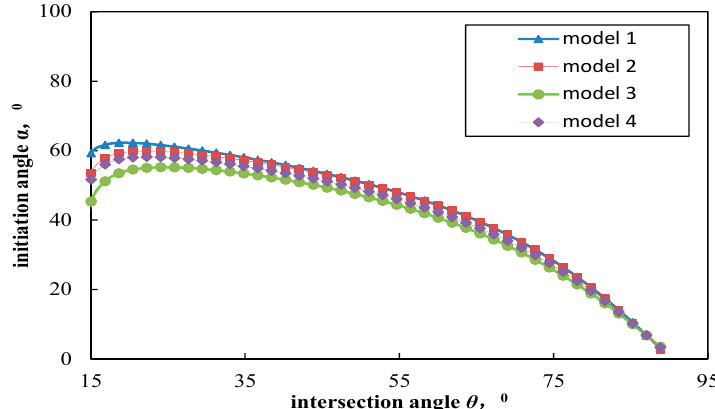
Figure 6. A comparison of different models. Model 1: single fracture and maximum circumferential stress crack criterion; model 2: single fracture and strain energy density; model 3: multiplied fracture and maximum circumferential stress crack; and model 4: multiplied fracture and strain energy